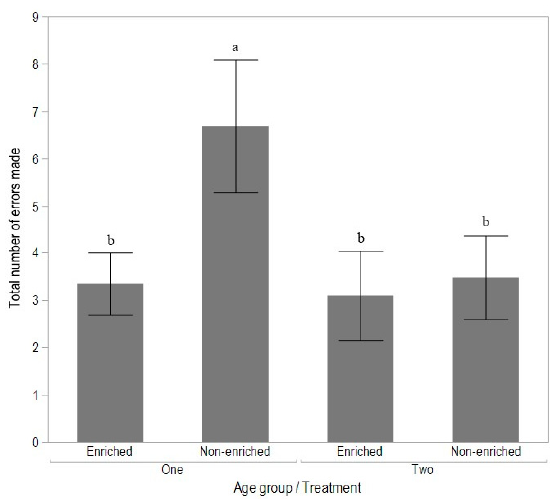
Figure 4. The total number of errors made in reaching the minimum 80% success criterion during T-maze learning for birds from enriched or non-enriched early rearing treatments and tested as Age group 1 (15 to 16 weeks of age) or Age group 2 (17 to 18 weeks of age). Different superscripts indicate significant differences between treatments across testing age groups ( p < 0.05).